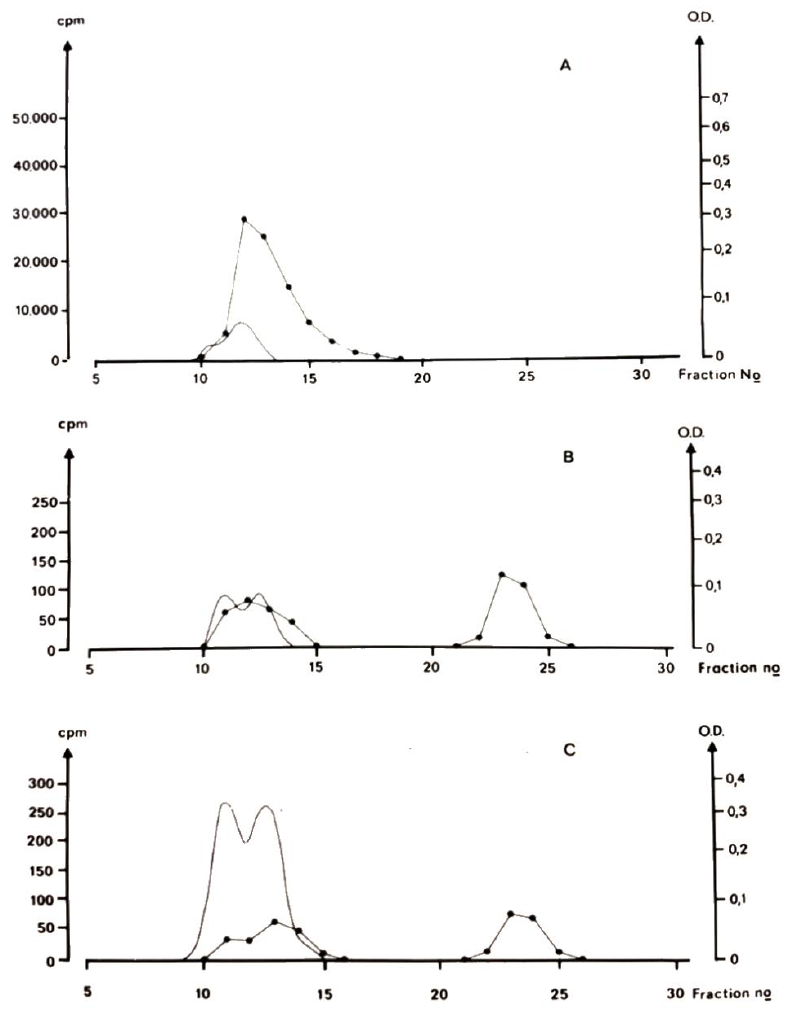
Figure 1. Binding of cadmium in blood plasma. The panels show the results of gel-chromatographic (G75) separation (at +5 °C) of blood plasma from mice at various time points after s.c. injection of a single dose of radiolabeled CdCl 2 . ( A ): 20 min after injection, ( B ): 96 h after injection, ( C ): 192 h after injection. At the shorter time (20 min) all Cd appeared in a high molecularweight peak (fractions 12–14). At longer longer times ( B , C ), when the concentration of Cd in plasma was 9 nanomol/kg, a considerable proportion of plasma Cd was detected in a second peak (fractions 23–24) at the molecular size of MT. Line with dots: radiocadmium, unbroken line optical density 254 nm (OD). (Picture of Original drawing of chromatographic results. Experimental details described in [27]).